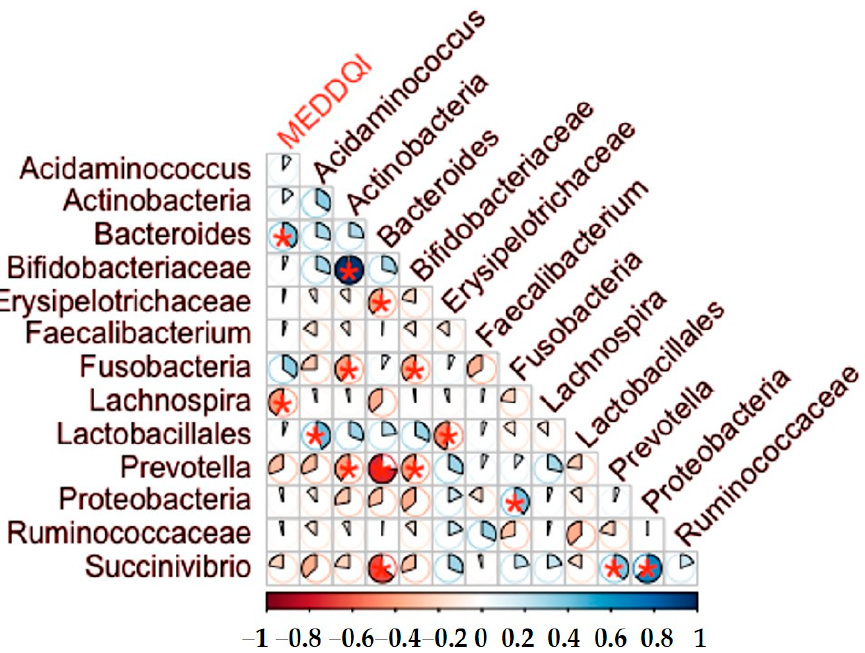
Figure 3. Heat map of correlations between MEDDQI and bacterial counts. The pie charts represent the magnitude of each individual Spearman Rho correlation coefficient in a color gradient from red (Rho − 1) to blue (Rho +1). Correlations with a p -value < 0.05 are marked with a red asterisk.